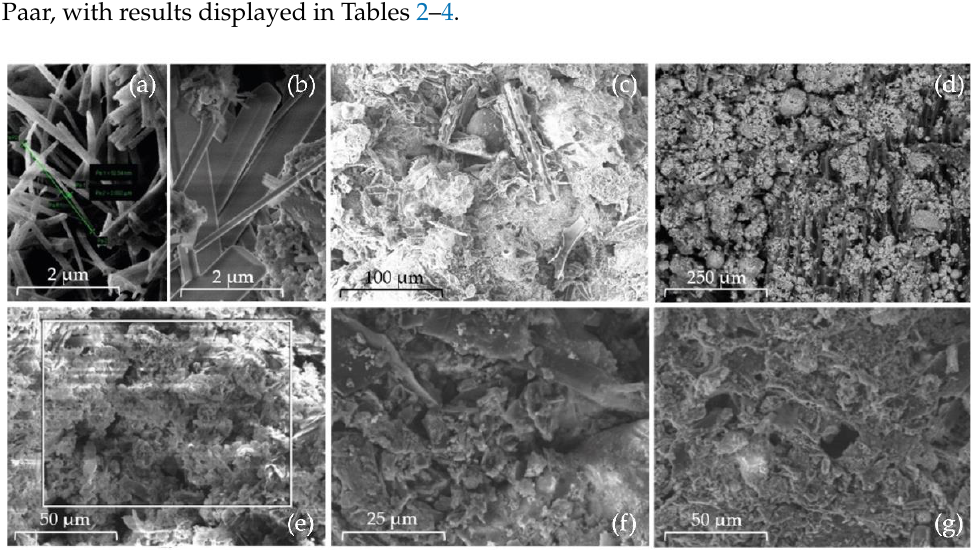
Figure 1. Microstructure of fly ash collected from various thermal power plants in the Czech Republic: ( a ) FA1—Louchovice CHP at 835 ◦ C, ( b ) FA2—Louchovice CHP at 615 ◦ C, ( c ) FA3—Cesky Krumlov, ( d ) FA4—Pisek, ( e ) FA5—Otin, ( f ) FA6—Mydlovy, ( g ) FA7—Trhove Sviny. Table 3. Crystalline phases of FA1 – 7 were detected by XRD analysis. Table 2. The chemical composition of fly ash collected from the thermal power plants in the Czech Republic. FA1 and FA2 were collected from the same thermal plant at Louchovice but with different combustion temperatures (835 ◦ C, and 615 ◦ C). The rest of the ash FA3–7 was collected at 725 ◦ C from various thermal